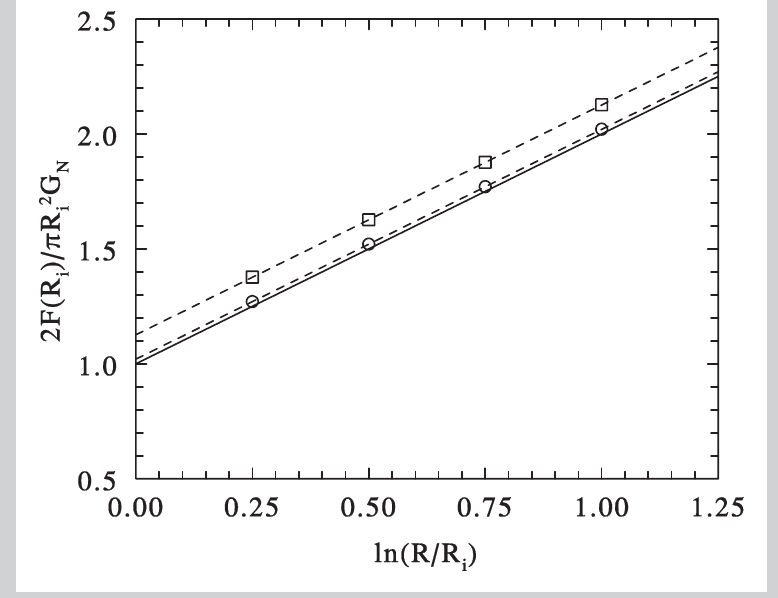
Figure 3: Normalized axial force on inner portion of plate with as a function of radius R i normalized sample radius R. Solid line shows ideal result with Ca = 0 and a/R = 1. Symbols show ‘measured’ values for Ca = 0, a = 0.1 and different values of a/R: a ( · ), 2 a ( Á